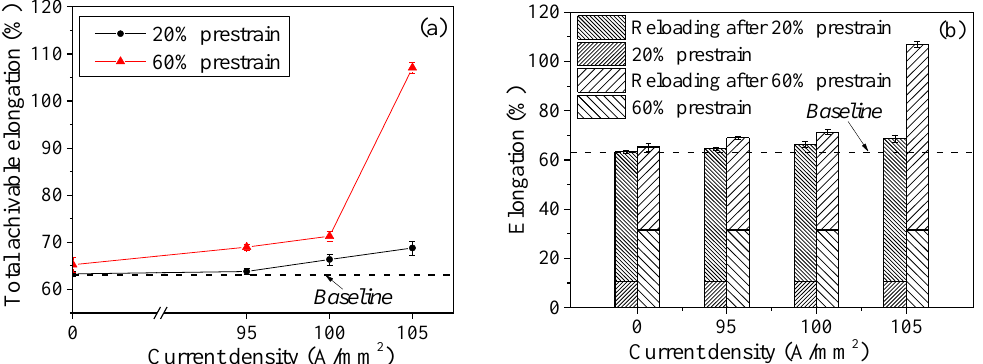
Figure 6. ( a ) Total achievable elongation as a function of current density and ( b ) the effect of prestrain and the current density on the total achievable elongation; the total achievable elongation was calculated based on the original gage length of the baseline specimen.